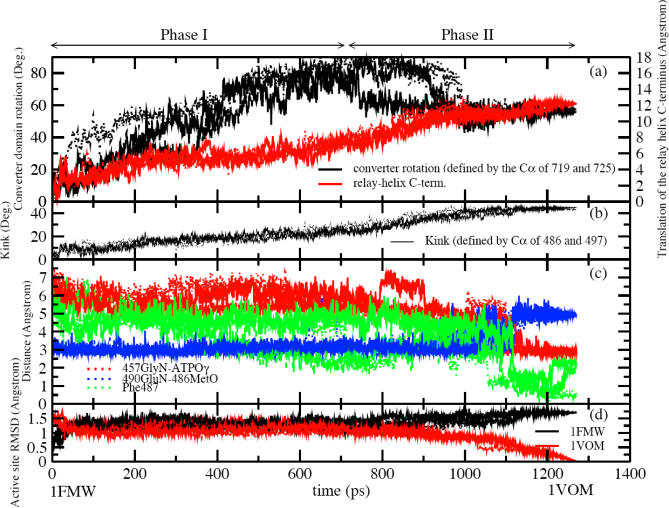
Variation of Critical Structural Parameters Along the Three TMD Trajectories for Illustrating the Sequence of Events Along the Approximation Transition Path between 1FMW and 1VOM(A) Synchronous progress of converter-domain rotation (angle on left axis, black line) and translation of the relay helix C-terminus (distance on right axis, red line).(B) The kink along the relay helix defined by the Cα of Met486 and the Cα of Glu497.(C) Successive local structural reorganizations: (i) formation of the hydrogen bond between Gly457 and the γ-phosphate of ATP (N457-Oγ distance, red line), (ii) breaking of the intrahelical hydrogen bond between Met486 and Glu490 in the relay helix (blue line), (iii) translation of Phe487 (green line).(D) The active site (Switch I, Switch II, and P-loop) backbone atom RMSD values relative to the two reference structures (1FMW and 1VOM) during the transition.